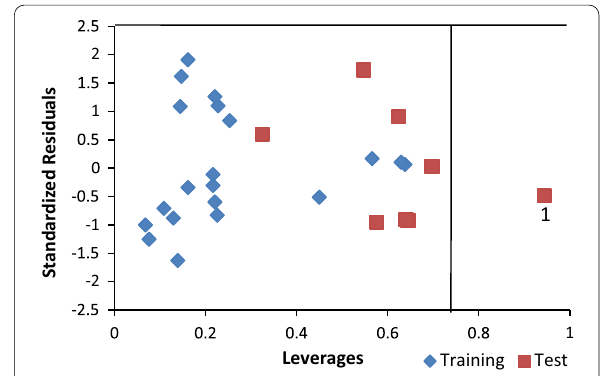
shows the plot of predicted activity values against those of experimental activity for both training and test sets. A further plot of standardized residuals against experimental activities was obtained and is presented in Fig. 2.